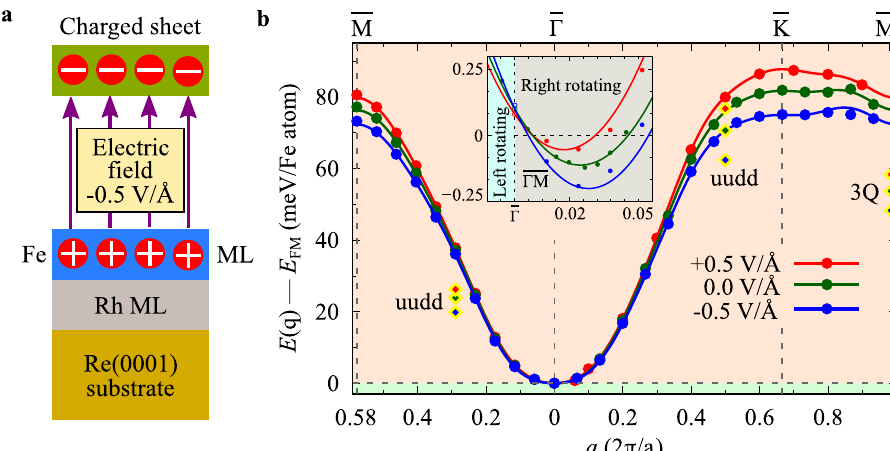
Fig. 1 Effect of electric fi elds on the spin spiral energy dispersion and multi- Q states. a Illustration of the Fe monolayer (ML) on a Rh ML on the Re(0001) surface, denoted as Fe/Rh/Re(0001), exposed to a perpendicular uniform electric fi eld. In the DFT calculation, the electric fi eld is created by a charged sheet located at 5.3 Å above the Fe layer. The direction of electric fi eld lines for E ¼ − 0.5 V/ Å is shown. b Energy dispersion E ( q ) of fl at spin spirals along two high symmetry directions ( Γ KM and Γ M ) without SOC at E ¼ + 0.5 V/ Å (red), E ¼ 0.0 V/ Å (green), and E ¼ − 0.5 V/ Å (blue). The fi lled circles represent DFT data and the solid lines are fi ts to the Heisenberg model. The fi lled diamonds, highlighted by the yellow border, represent the multi- Q (3 Q and uudd ) states without SOC, which are shown at the q points of the corresponding single- Q states (see Fig. 6 for spin structures). Inset shows E ( q ) of fl at cycloidal spin spirals including DMI and MAE along Γ M for zero and two fi nite electric fi elds. The fi lled circles represent DFT data and the solid lines are fi ts to the Heisenberg plus DMI spin model (see text for details). Grey (cyan) shaded region indicates right (left) rotating spin spirals. Note that the MAE shifts E ( q ) by K /2 with respect to the FM